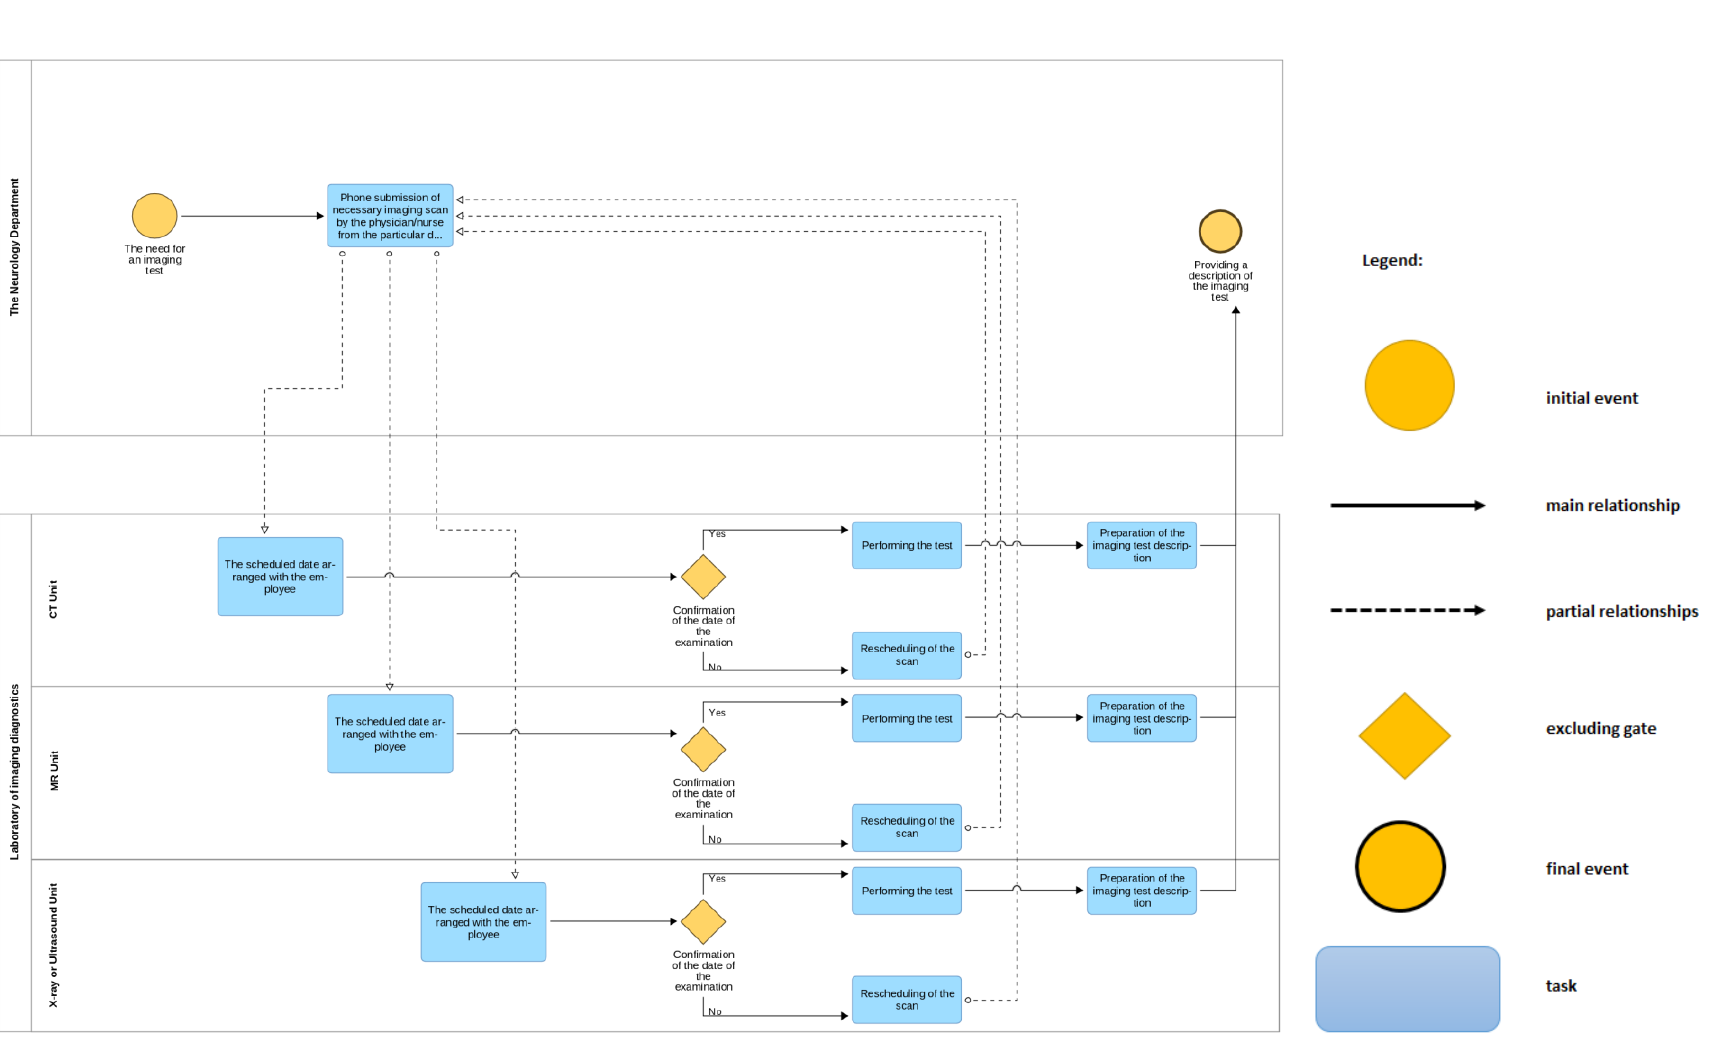
Figure 3. The flowchart of the imaging scan process.